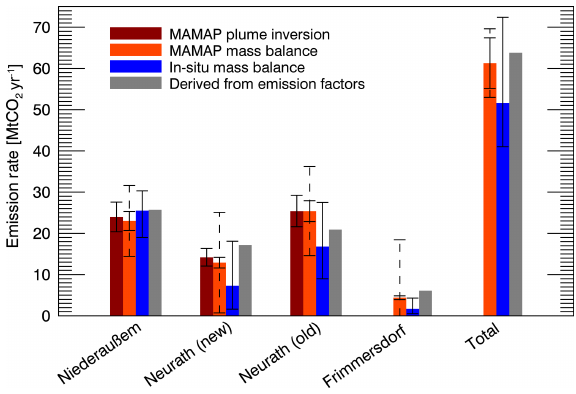
Figure 16. Inversion results compared to results obtained from emission factors and energy production for the time of the over- flights. For the remote sensing mass balance approach the smaller error bars denote the uncertainties derived from the sensitivity anal- ysis, while the larger also include the precision (see Fig. 15) by ap- plying the root sum square. The error bars for in situ are worst-case limits based on the sensitivity analysis and half of the extrapolated emissions below and above of the captured plumes. Emissions from Frimmersdorf were not evaluated with the remote sensing plume